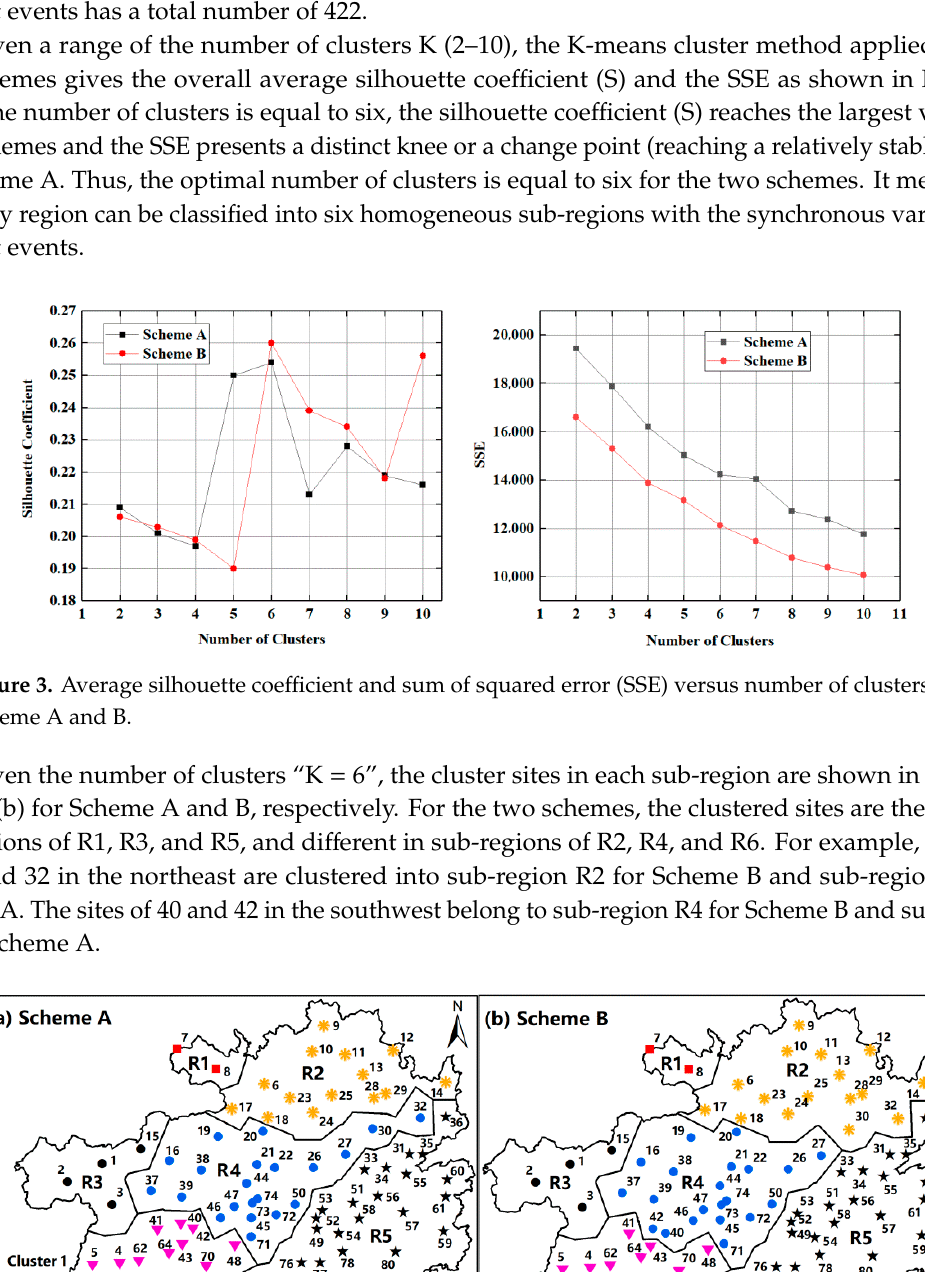
Figure 3. Average silhouette coefficient and sum of squared error (SSE) versus number of clusters for Scheme A and B.